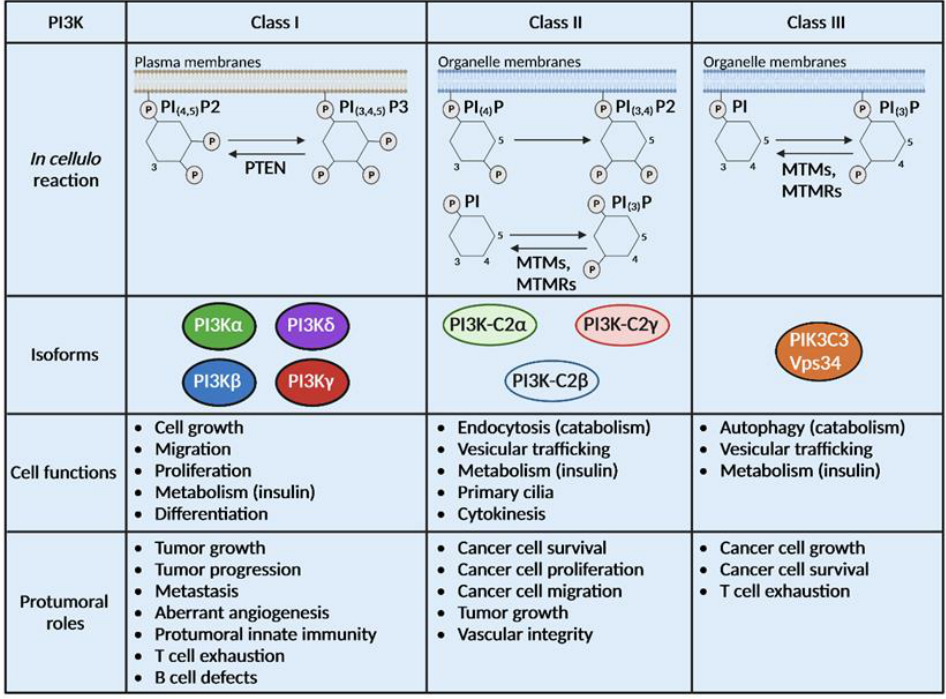
Figure 1. PI3Ks are divided into 3 classes with different substrates and functions. Class I, II and III PI3Ks catalyze the same biochemical reaction on distinct substrates localized at the plasma membrane or the organelle membrane. Some phosphatases can catalyze the opposite reaction of PI3Ks such as Phosphatase and Tensin homolog (PTEN), myotubularin (MTM) and MTM-related protein (MTMR). Class I is composed of 4 isoforms (PI3Kα, β, δ and γ), class II of 3 isoforms (PI3K - C2α, β and γ) and class III has only one isoform, Vps34. Physiological and pro-tumoral functions of class I PI3Ks are well described while limited information is available on the roles of class II and III PI3Ks in cancer.